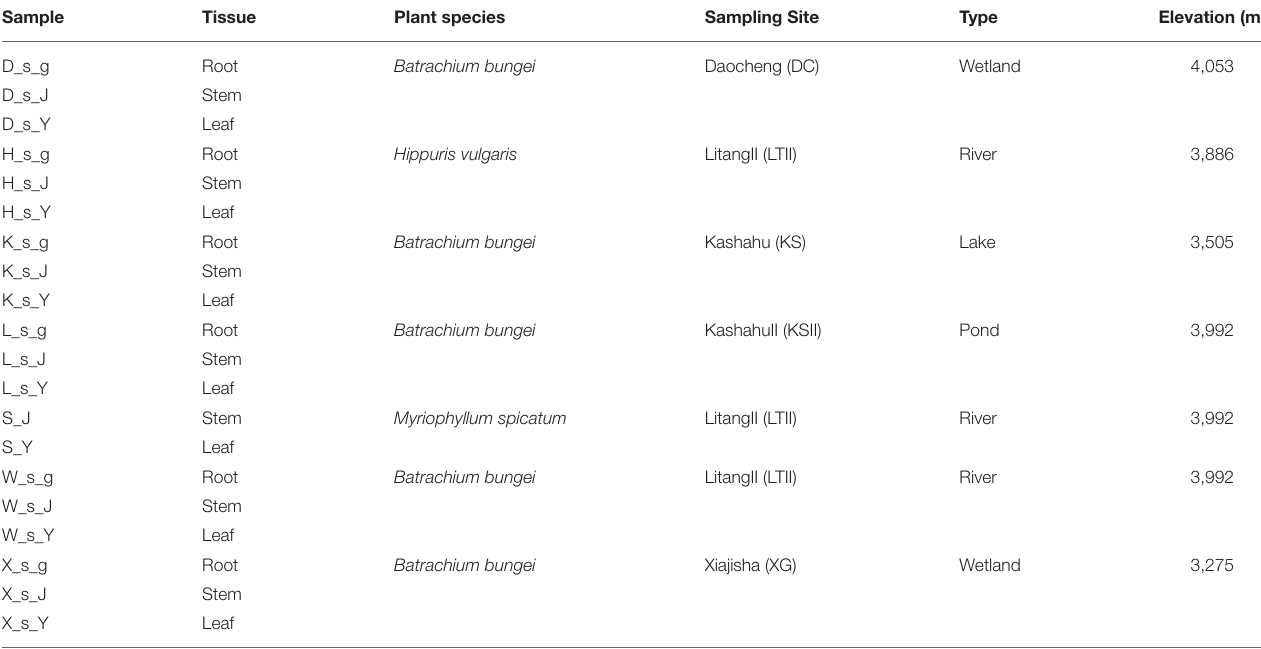
TABLE 2 | The detail information of samples for high-throughput sequencing. Sample